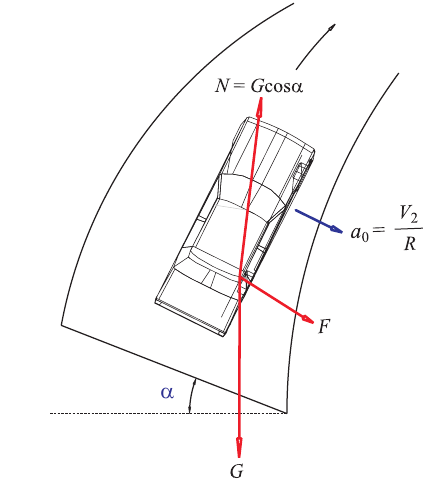
Fig. 2. Traveling at curve with superelevation section